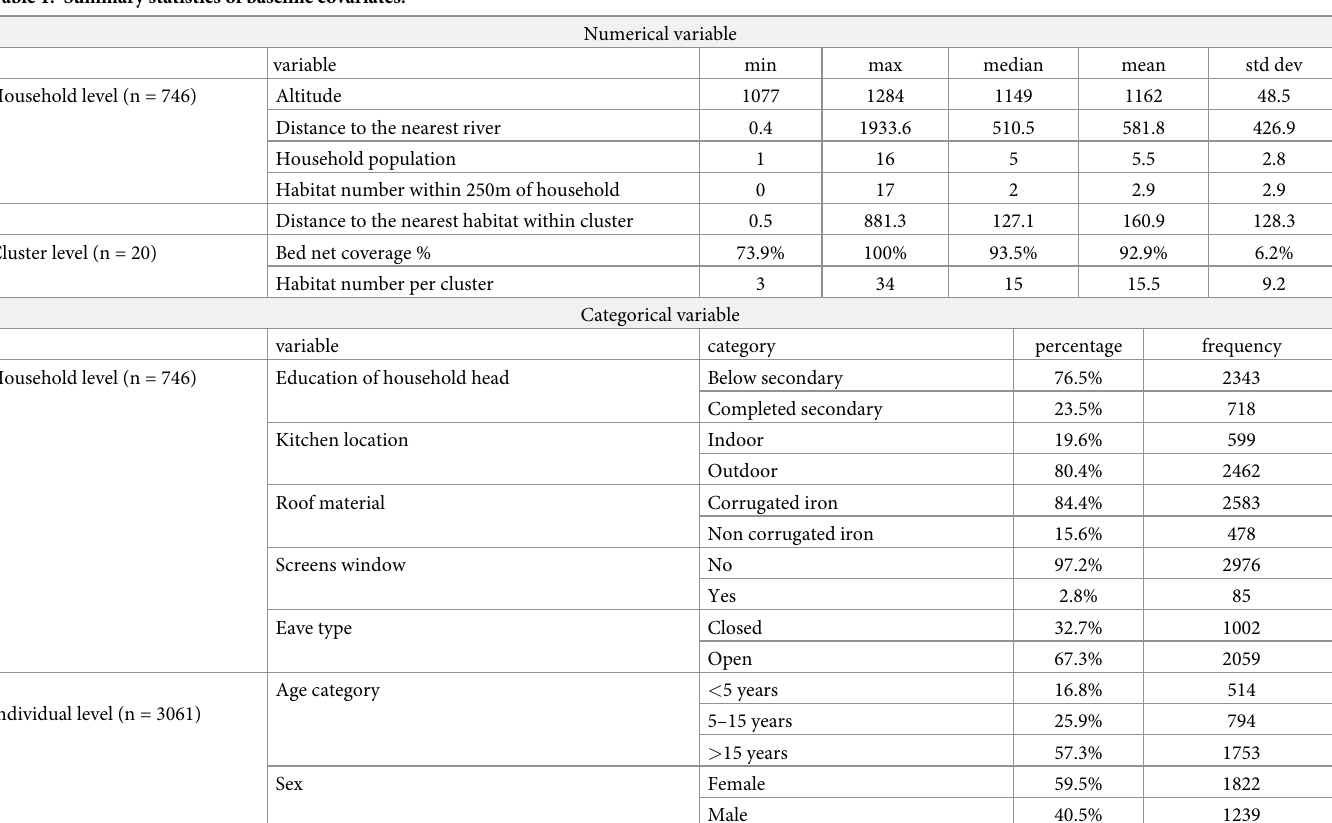
Table 1. Summary statistics of baseline